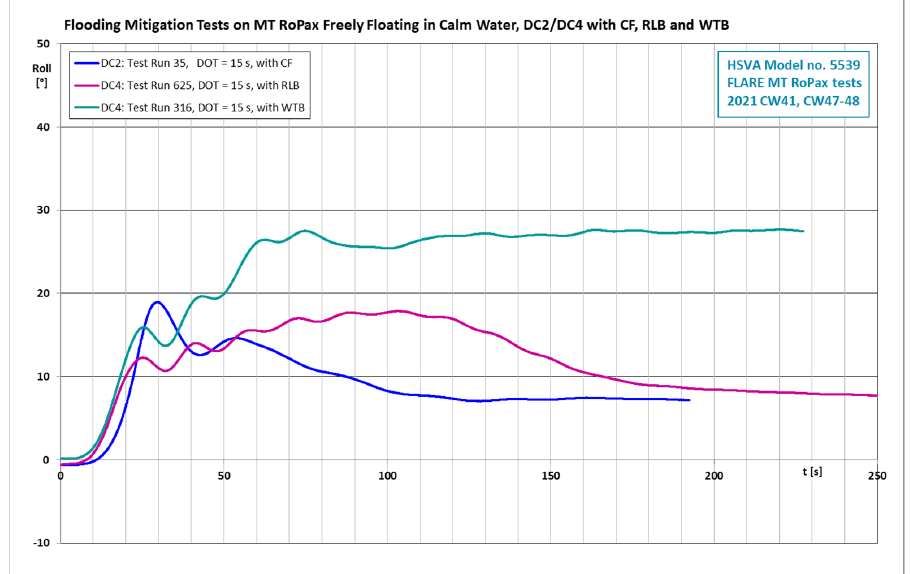
Figure 22. Qualitative comparison of the three different flooding mitigation methods on two damage cases: counter flooding (CF), recovery of the lost buoyancy (RLB), and deployment of the watertight barrier (WTB).